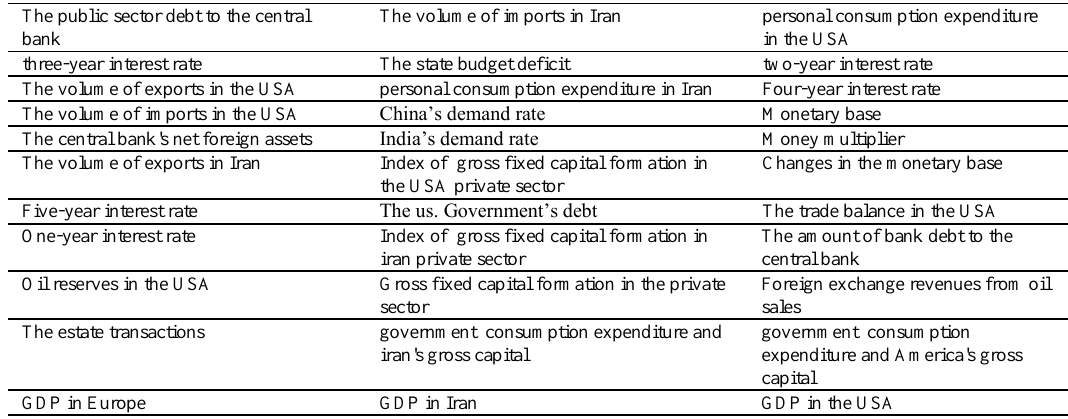
table. In the MLP method, the number of input neurons equals 55, the number of hidden layer neurons equals 9, and one neuron in the outer